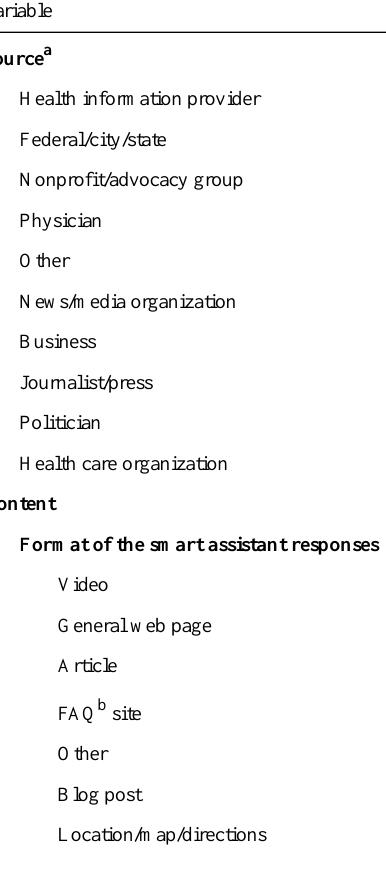
Table 2. Source and content characteristics of smart assistant